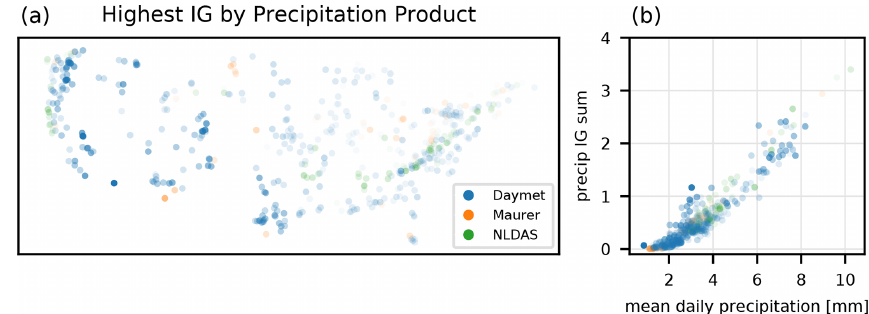
Figure 8. The forcing product, with the highest overall contribution (sensitivity) in each basin (a) , averaged over the prediction time step and lag. The alpha value (opacity) of each dot on this map is a relative measure of the fraction of the total integrated gradients of all three precipitation products (summed over time, lag, and product) due to the highest-contributing product. Panel (b) shows that the total integrated gradient summed over all three precipitation products is highly correlated with total precipitation in the basin.